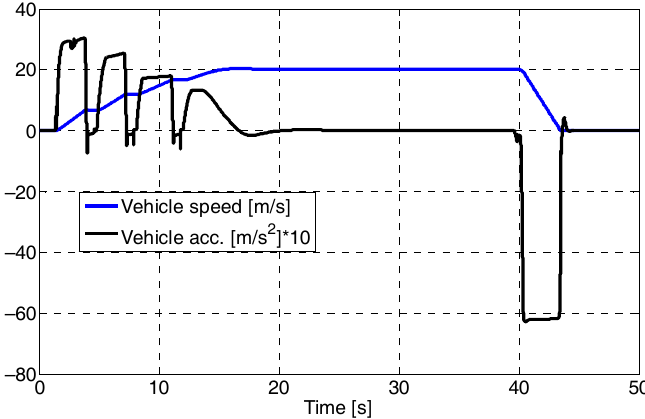
Figure 11. Straight line braking manoeuvre. The blue profile represents the actual vehicle speed and the black curve is the vehicle longitudinal acceleration.